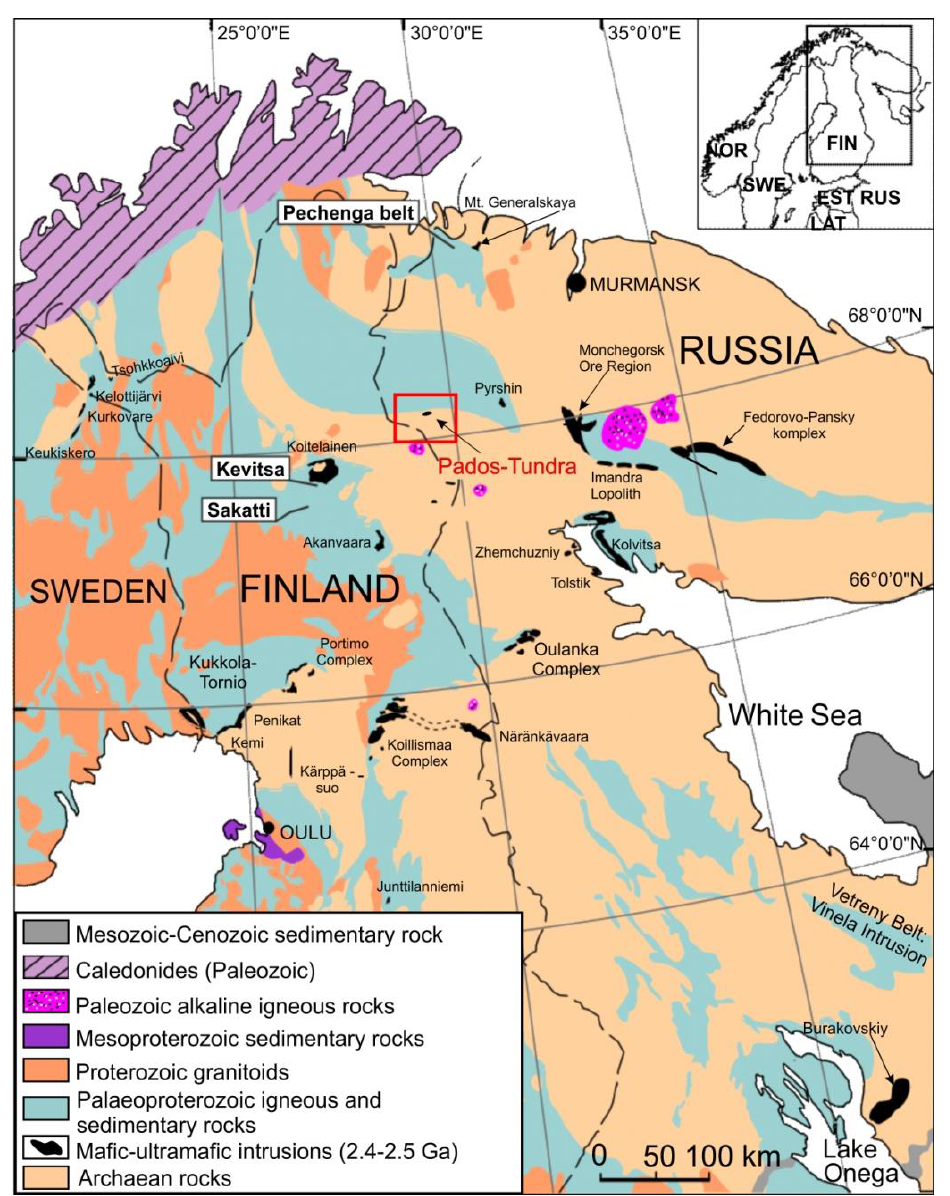
Figure 1. Map of mafic–ultramafic layered intrusions (2.53–2.39 Ga) in the Fennoscandian Shield, modified after [5,41].